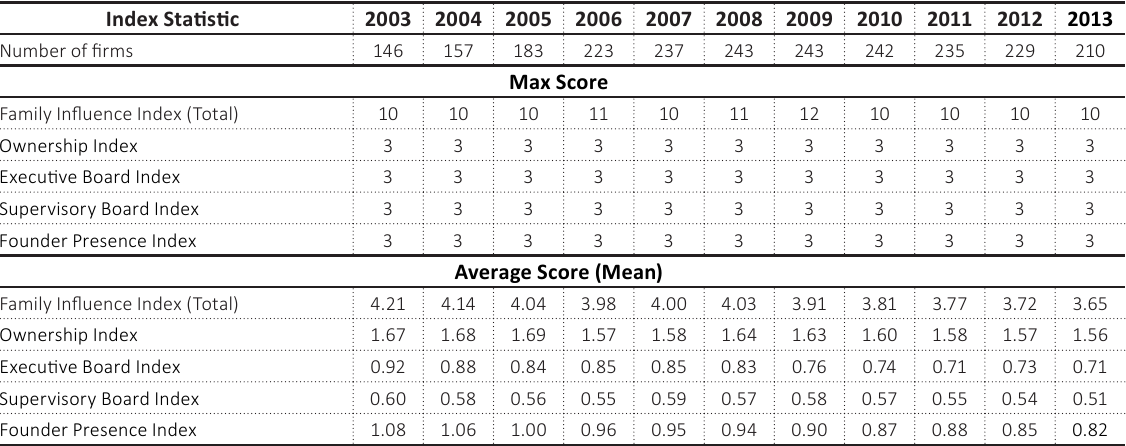
Table 3. Family influence index